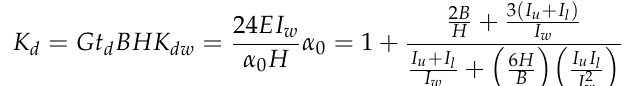
Figure 6. Variations in the distortional warping normal stress with the stiffness ratio.